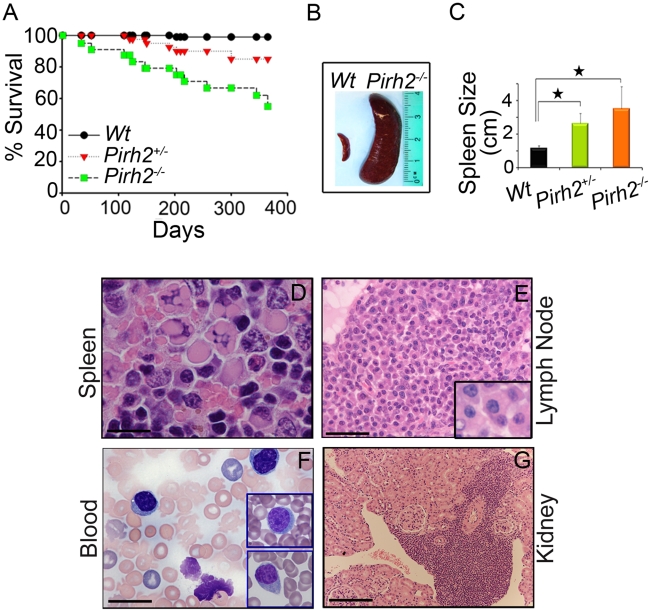
Shorter Life Span and Plasma Cell Hyperplasia of Pirh2 Mutant Mice.(A) Kaplan-Meier analysis representing the percent survival versus age in days of cohorts of Wt (n = 30), Pirh2+/− (n = 40) and Pirh2−/− (n = 25) mice. Log-rank test, P<0.046 between Pirh2+/− mice and Wt controls; P<0.0001 between Pirh2−/− mice and Wt controls. (B) Representative splenomegaly associated with Pirh2 mutation. (C) Size of spleens from Wt (n = 8), Pirh2+/− (n = 5) and Pirh2−/− (n = 8) 10 to 12 month-old mice. Student's t test was used for statistical analysis. Stars indicate P<0.005. Error bars represent SD. (D) H&E staining of Pirh2−/− spleen sections showing plasma cells with Russell bodies (Bar = 20 µm). (E) H&E staining of sections from grossly enlarged Pirh2−/− lymph nodes showing focal infiltrates of a large number of plasma cells (Bar = 50 µm; inset: bar = 20 µm). (F) Blood smear performed on Pirh2−/− mice showing atypical plasma cells (Bar = 20 µm; inset: bar = 20 µm). (G) H&E staining of Pirh2−/− kidney sections showing plasmacytoid aggregates infiltrating the kidney interstitium (Bar = 100 µm).